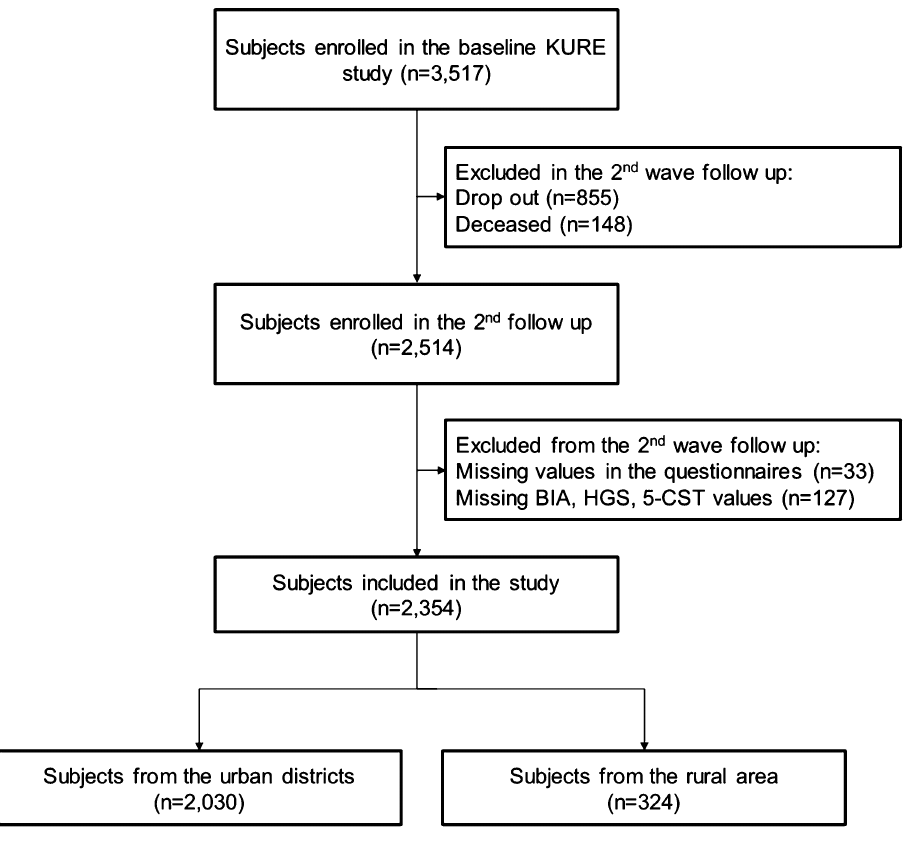
Figure 1. Flow diagram of the participants who were included in the study. BIA bioelectrical impedance analysis, HGS handgrip strength, 5-CST 5-times chair standing test